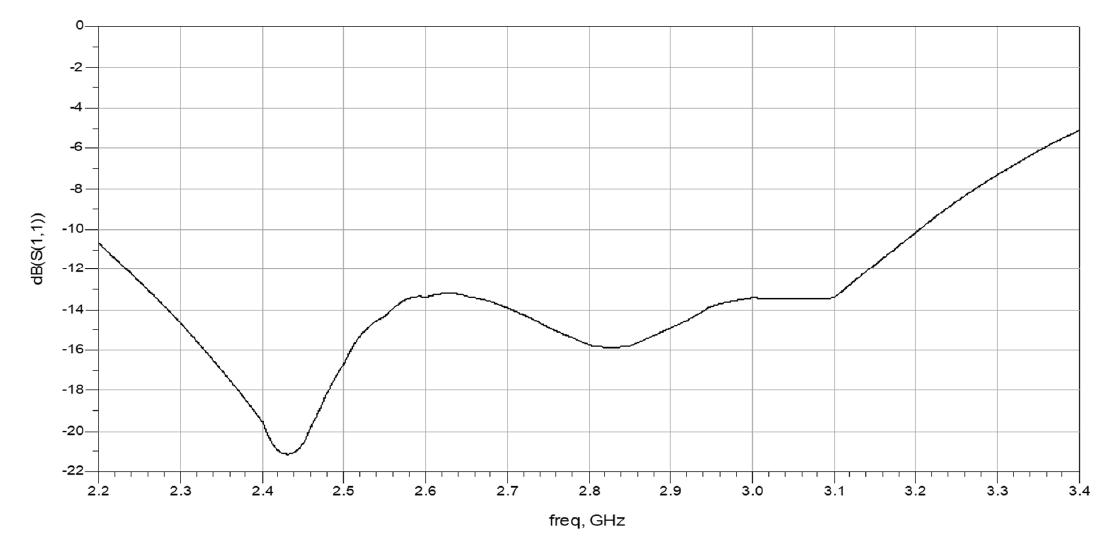
Figure 16. Double layer active circular patch antenna S11 parameter on a human body.